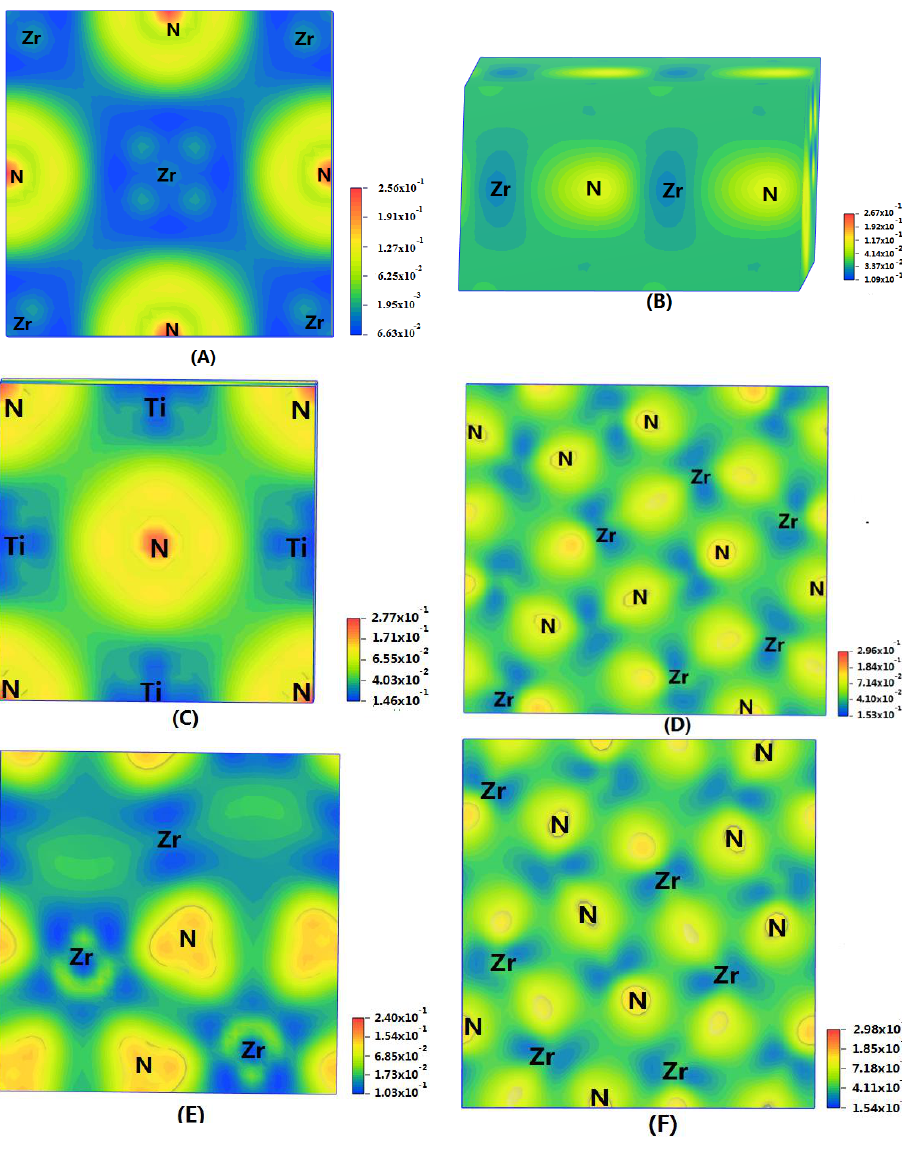
Figure 3. Total density of states plots and partial density of states plots of ( A ) ZrN with space group 一 Fm3 m; ( B ) ZrN with space group P6 3 mc; ( C ) TiN, ( D ) Ti 2 N with space group P4 2 /mnm; ( E ) Ti 2 N with space group I4 1 /amdz; ( F ) Zr 3 N 4 with space group Pna2 1 ; ( G ) Zr 3 N 4 with space group Pnam; ( H